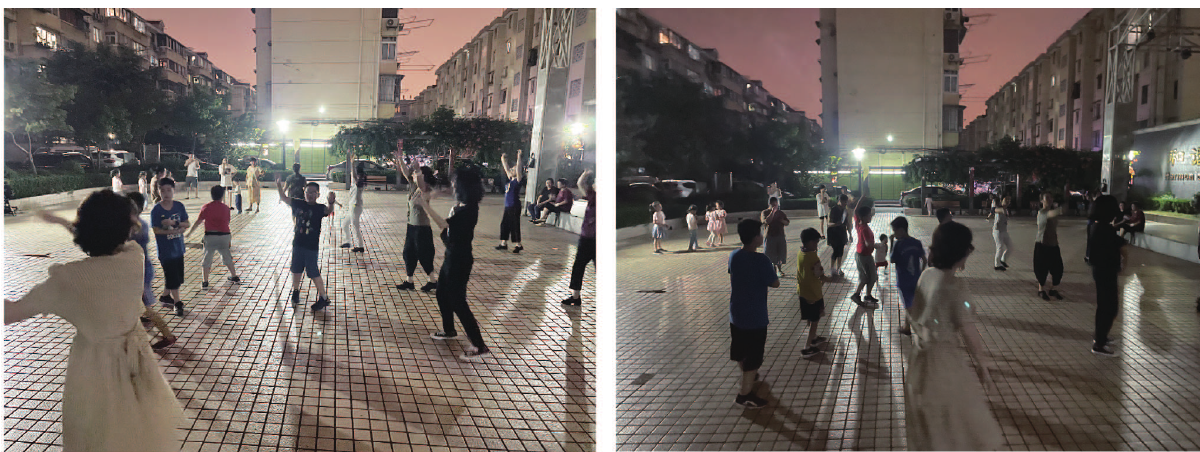
Figure 6Figure 6. Community residents of all ages dancing together in a public